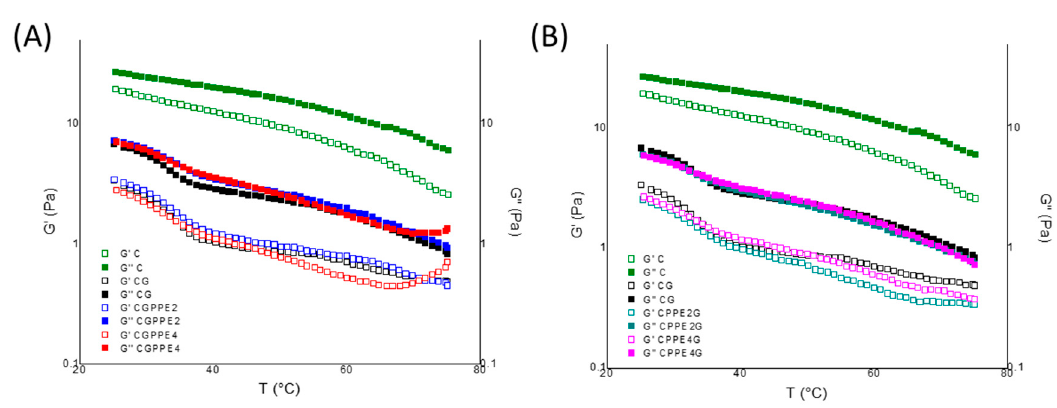
Figure 3. G (cid:48) and G (cid:48)(cid:48) moduli as a function of temperature (from 25 to 75 ◦ C) for: ( A ) C, CG, CGPPE2, and CGPPE4; and ( B ) Figure 3. G’ and G’’ moduli as a function of temperature (from 25 to 75 °C) for: -(A) C, CG, CGPPE2, and CGPPE4; and C, CG, CPPE2G, and (B) C, CG, CPPE2G, and CPPE4G.